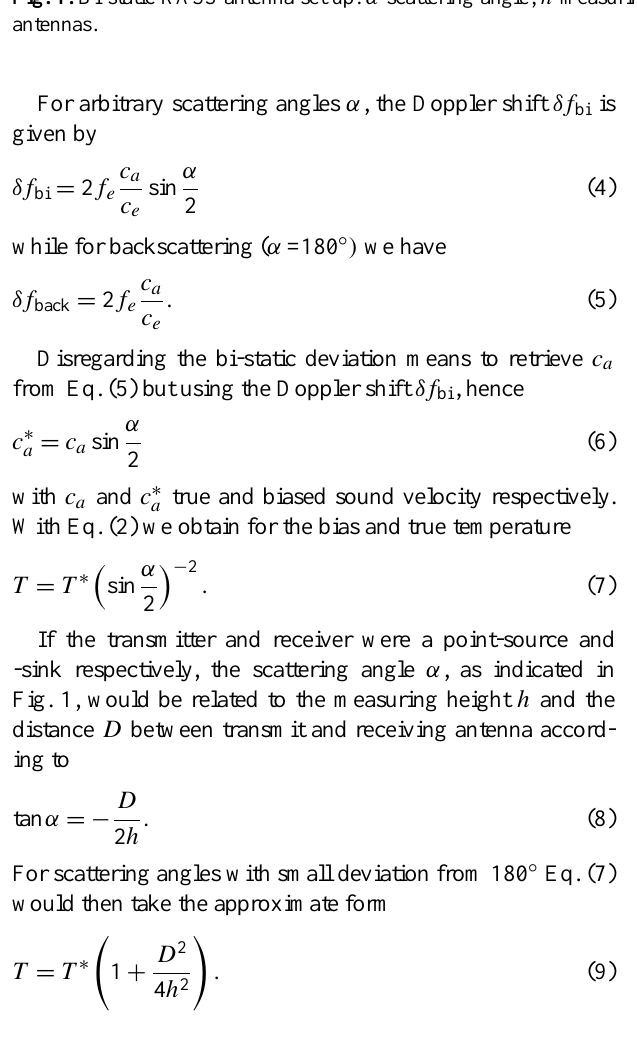
α s atteringangle,hmeasuringheight,Ddistan ebetweenele tromagneti